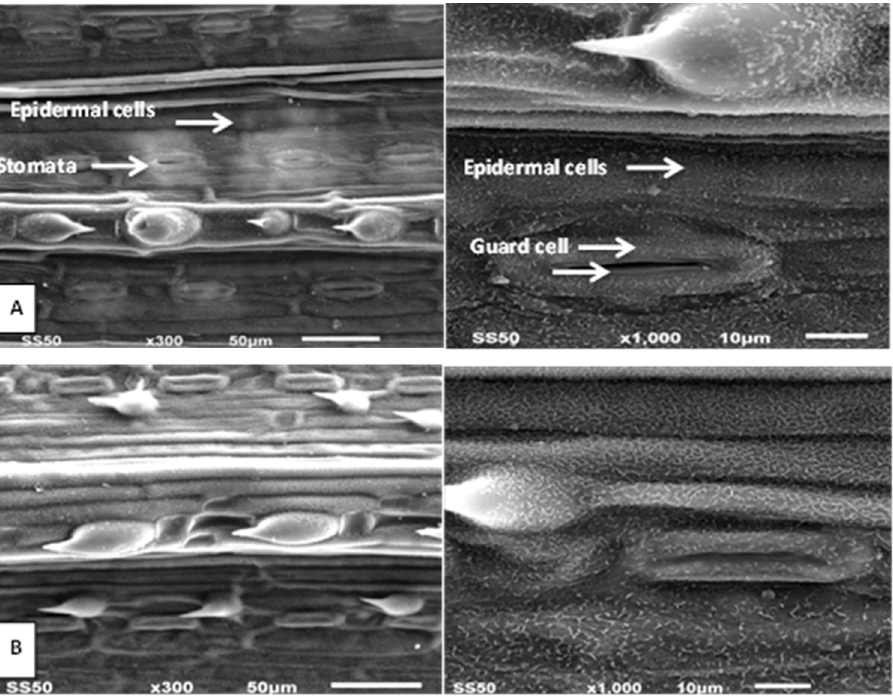
Figure 2. Effects of drought on barley leaves (Scanning Electron Microscope image). ( A ) Control. ( B ) plants irrigated once. Bar = 10 μ m, Bar = 50 μ m. (Abdelaal et al. [2]).